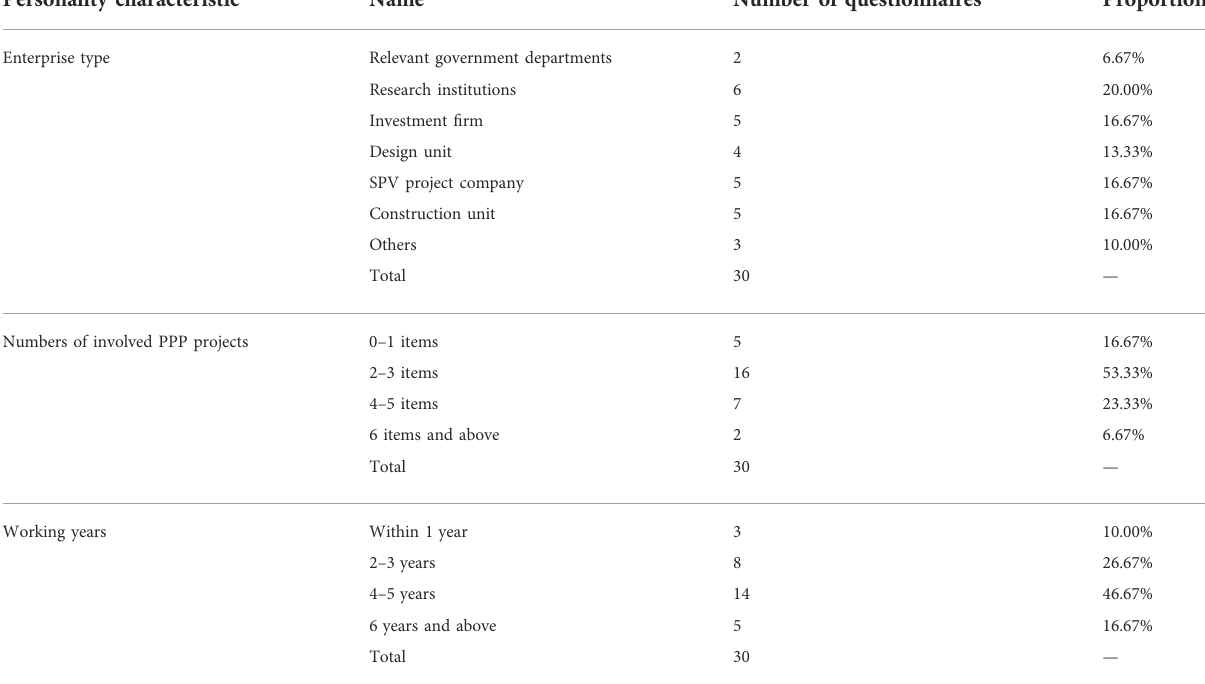
TABLE 2 Characteristics of the questionnaire